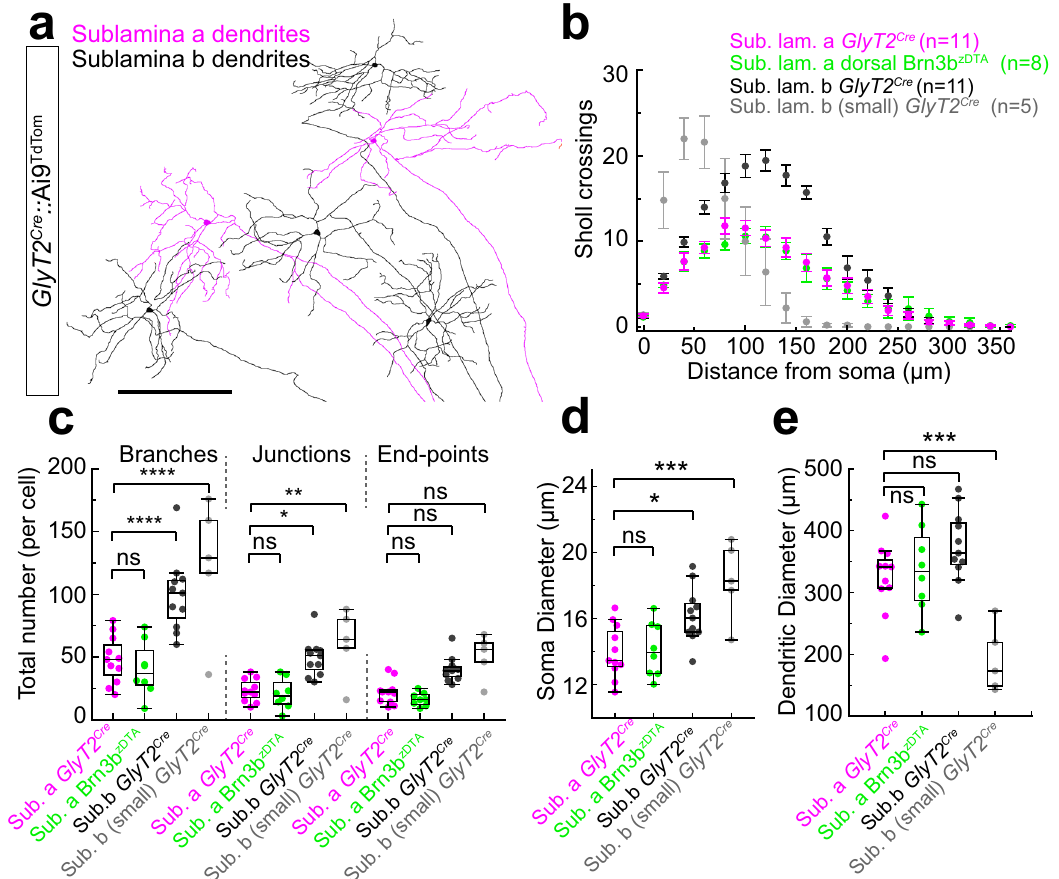
GlyT2 Cre sublamina-a stratifying ipRGCs (M1; n =11 cells from n =5 animals), OPN4 Cre ;Brn3b zDTA ipRGCs (M1; n =8 cells from n =1 animal), GlyT2 Cre -positive sublamina-b stratifying ipRGCs (M2; n =11 cells from n =5 animals), small sublamina-b stratifying ipRGCs (M4/5; n =5 cells from n =4 animals). Dendrites of OPN4 Cre ;Brn3b zDTA M1 ipRGCs were reconstructed from the antibody-stained retina. Dendrites of M1, M2, and some M5 ipRGCs were reconstructed from Neurobiotin- fi lled cellsin GlyT2 Cre ;Ai9 mice.Datawerepresentedasmeanvalues±SEM.Boxand whiskerparametersareprovidedinSupplementaryTable3andinasourcedata fi le. Scale bar in ( a )=300 μ m. Source data are provided as a source data fi